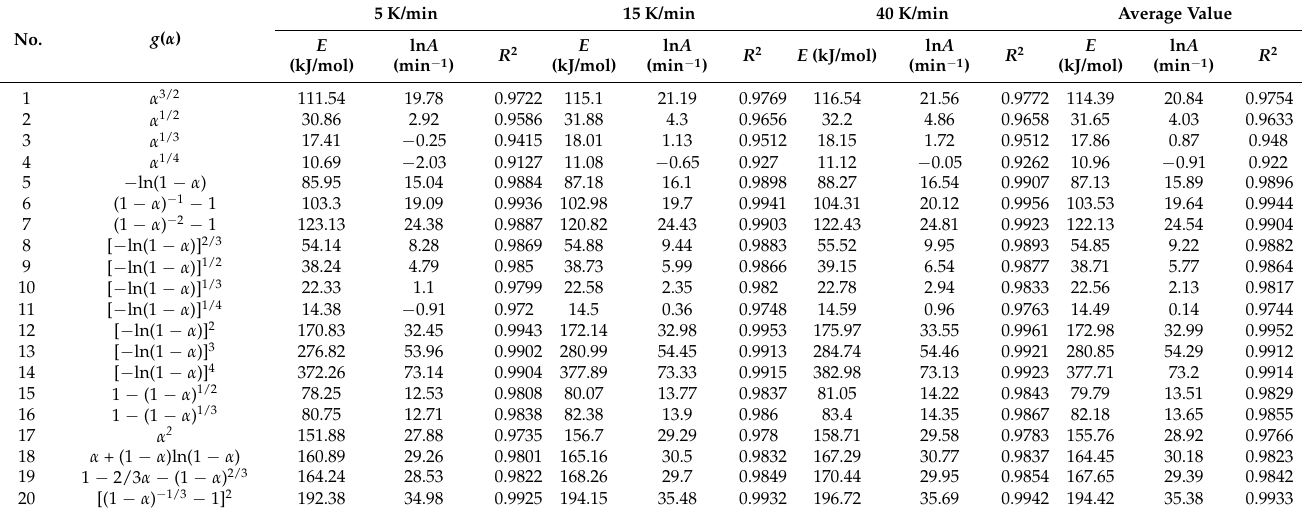
Table 4. E , ln A , and R 2 values of hardwood computed via the CR approach with 18 kinetic models at different heating rates in region 1.